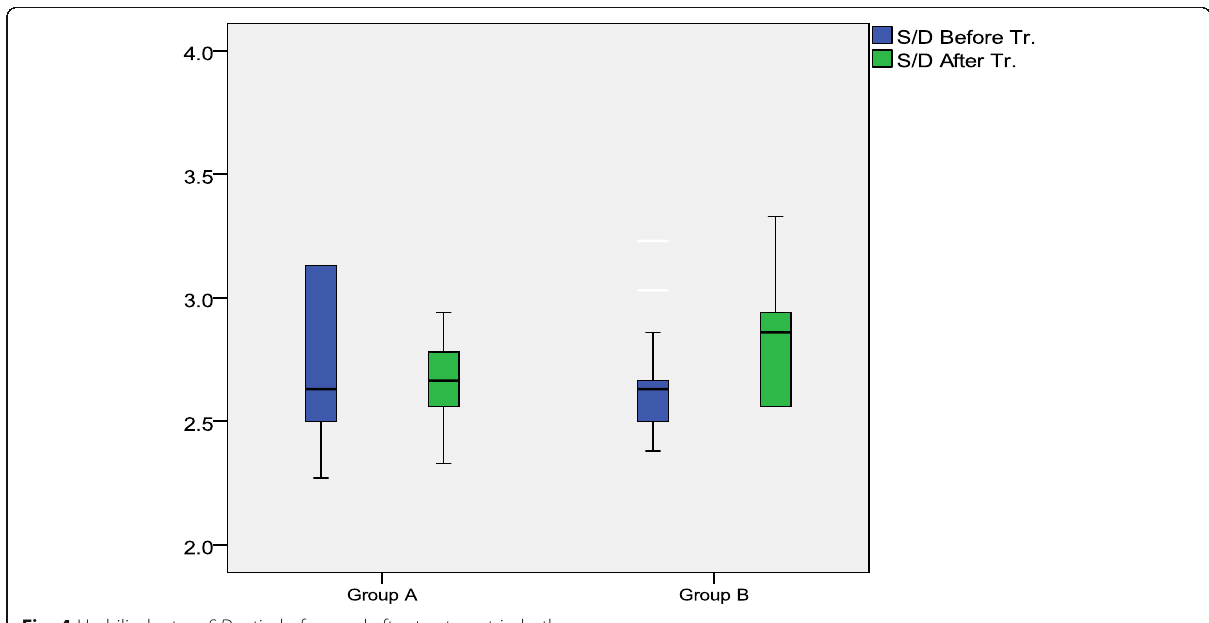
Fig. 4 Umbilical artery S : D ratio before and after treatment in both